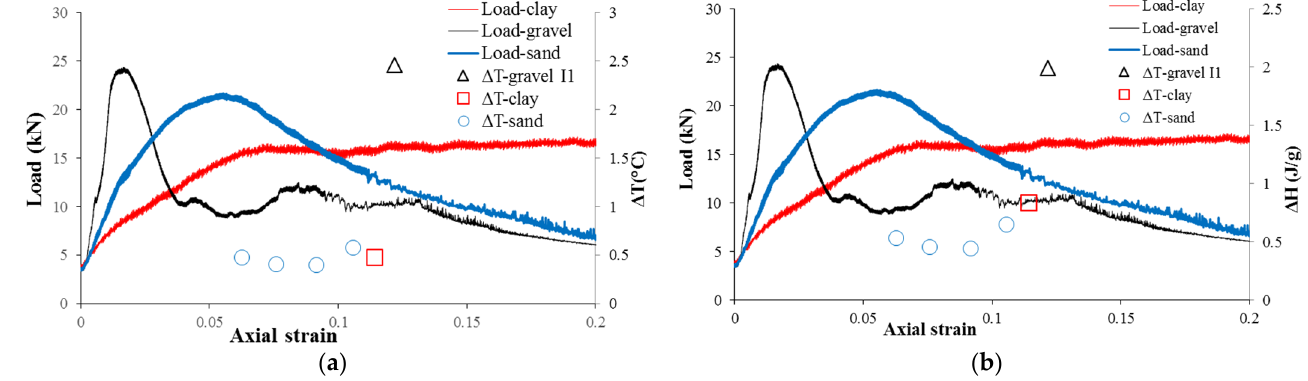
Figure 19. Inter-particle friction in frozen soils: ( a ) comparison of Δ𝑇 with stain and load; and ( b ) comparison of Δ𝐻 with stain and load. Table 2. Values of C m from the literature.